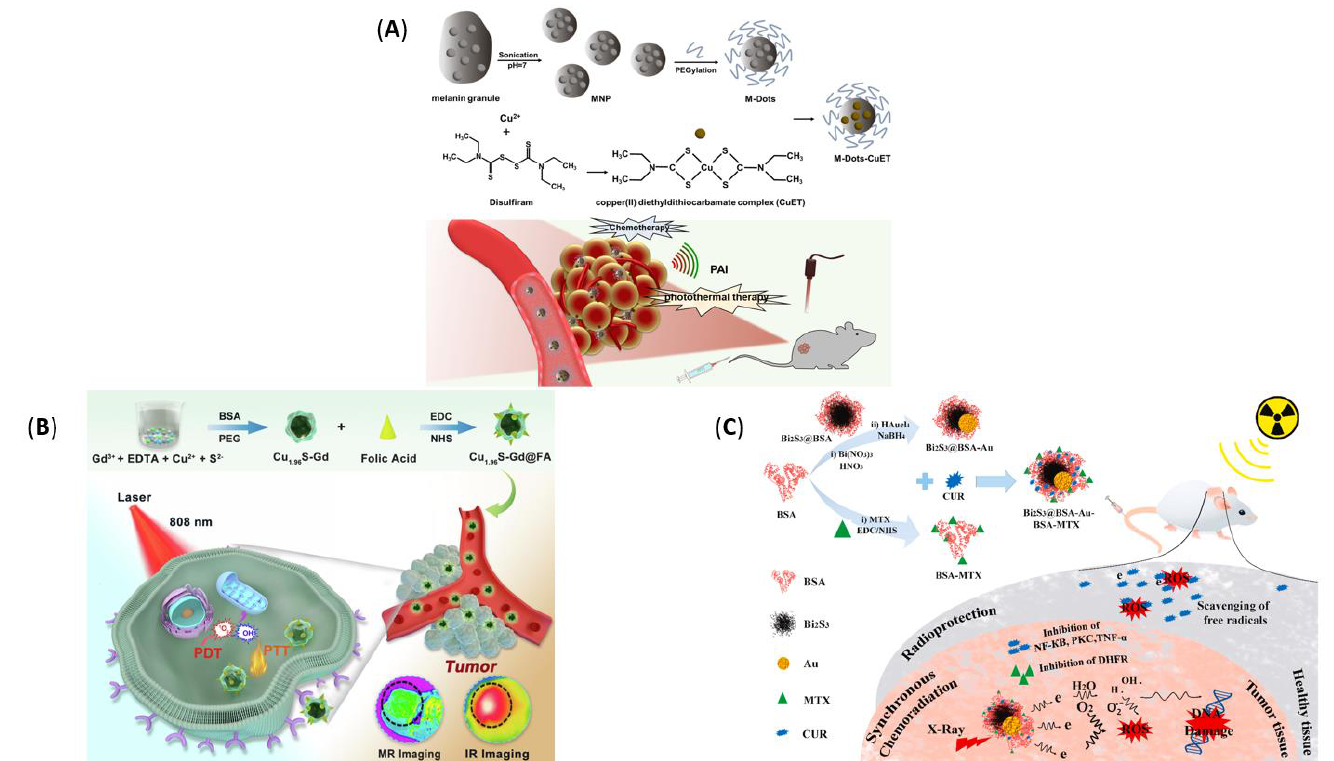
Figure 12. ( A ) Schematic representation of the synthesis of M-Dots-CuET and the process of PAI- guided chemo/photothermal therapy using M-Dots-CuET. Reproduced with permission from [191], Elsevier B.V., 2021. ( B ) Schematic representation of the preparation of dual-modal MR/IR imaging- guided synergistic PTT/PDT with Cu1.96S-Gd@FA nanoparticles. Reproduced with permission from [192], Elsevier B.V., 2022. ( C ) Schematic representation of the synthesis process and tumor ab-